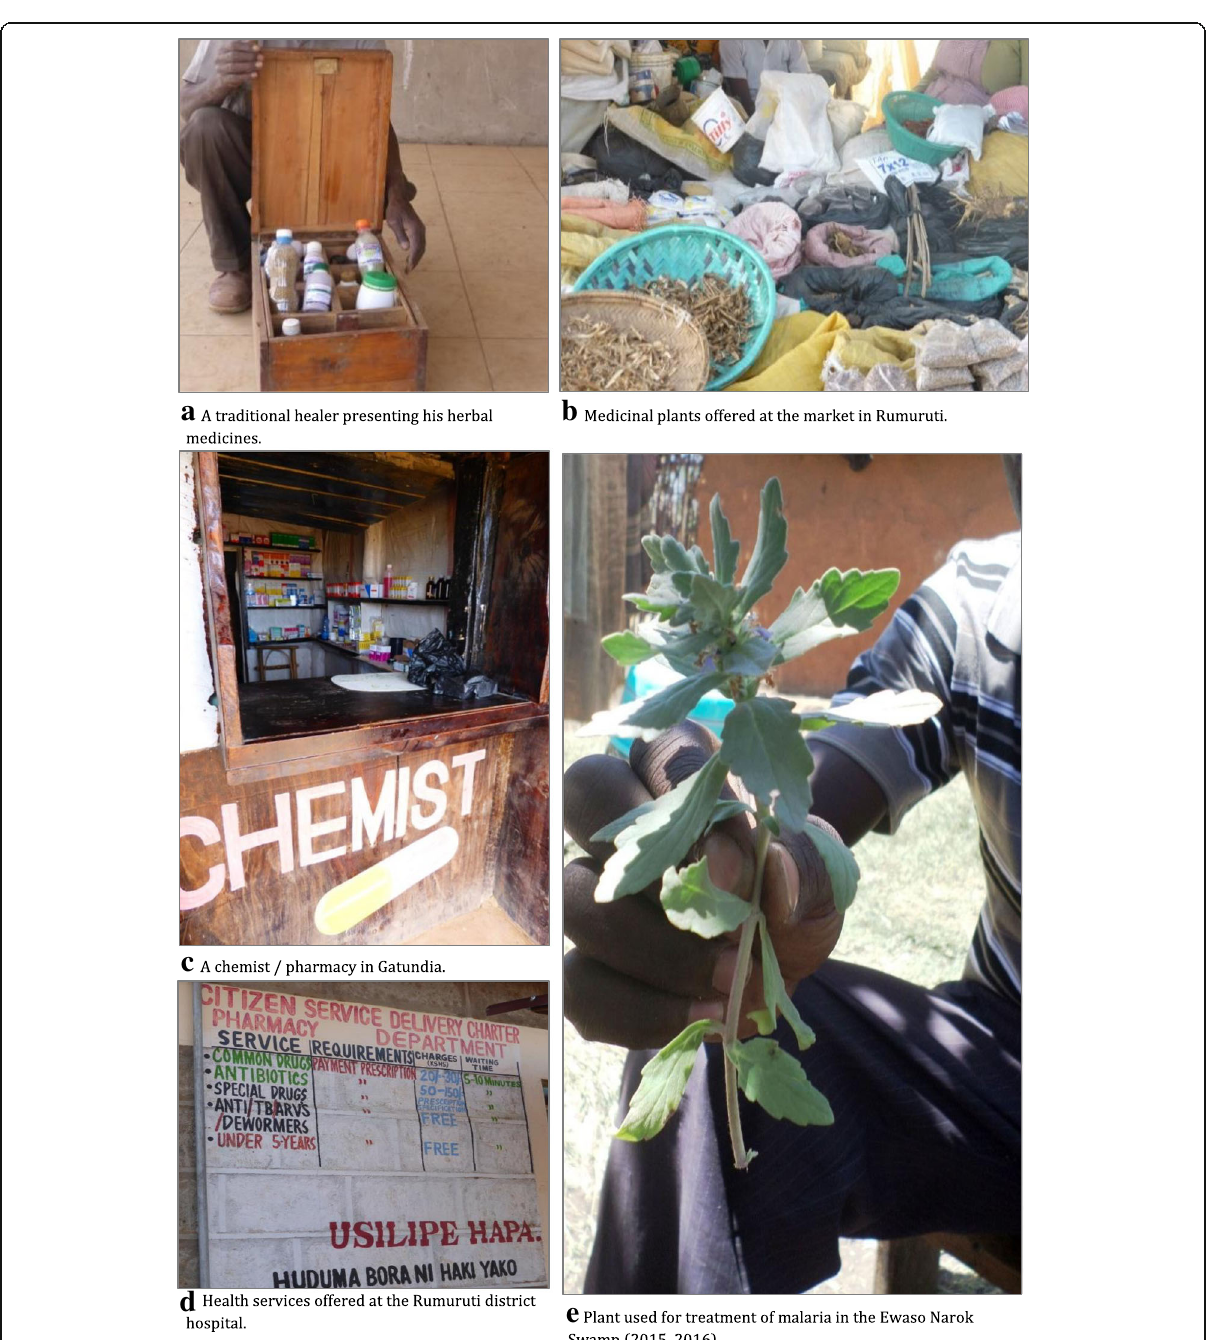
Fig. 7 Healthcare options in the Ewaso Narok